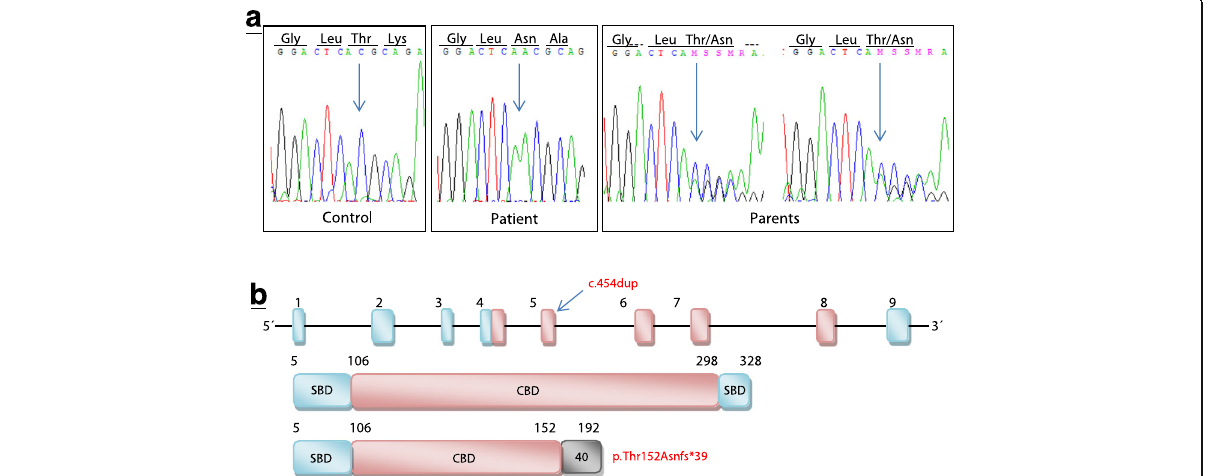
Fig. 3 The structure of GRHPR gene and protein and sequences with mutation c.454dup. a Sequences show a control samples without mutation and a duplication of nucleotide A in homozygous (patient) and heterozygous state, which changes the followed amino acids from origin threonine to asparagine. The last two sequences are the parents of the patient. b Arrow shows the localization of this mutation in gene GRHPR (in exon 5) and diagram shows a predicted shorted protein. Boxes indicate exons and lines indicate introns. The coenzyme-binding domain (CBD) is indicated by a red box and two the formate/glycerate dehydrogenase substrate-binding domain (SBD) are indicated by blue boxes . The grey box indicates the length of additional amino acids that is appended as a result of the frame-shifting